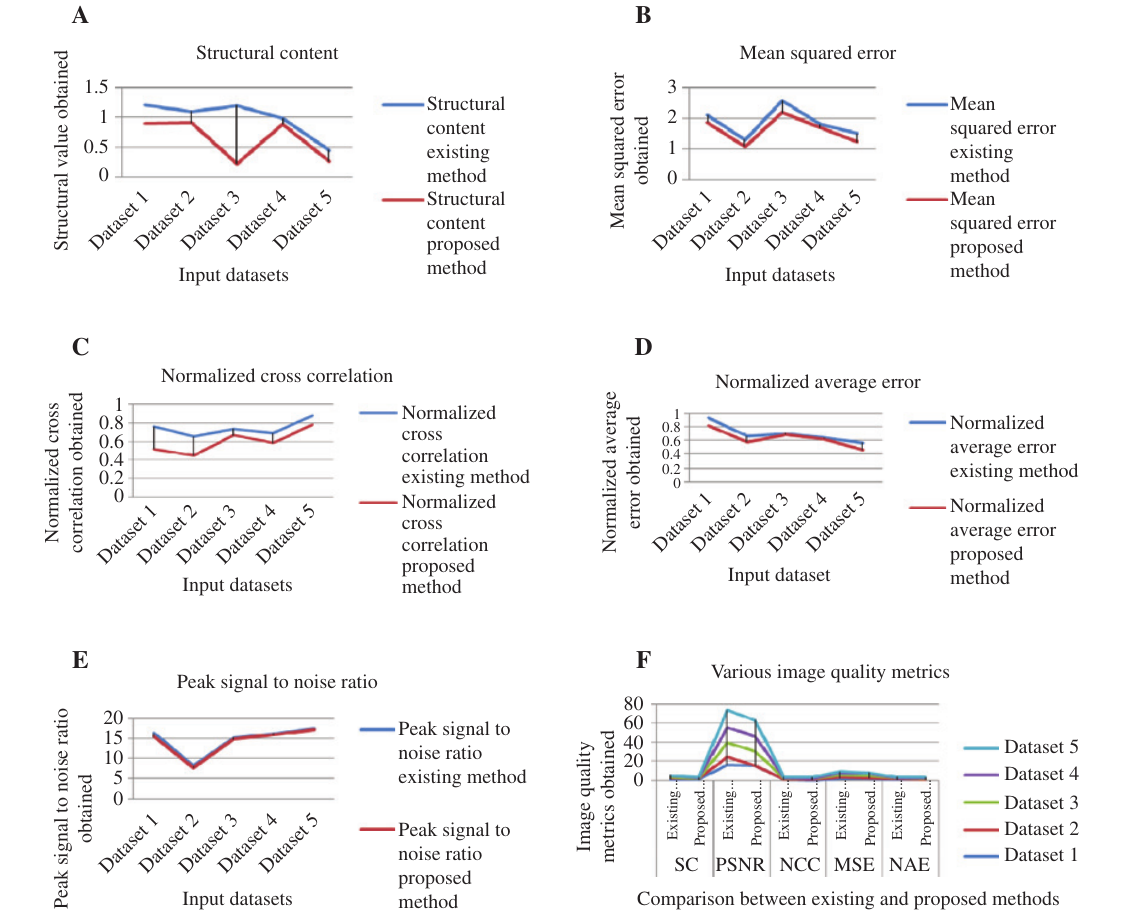
Figure 4: Comparative Graphical Illustration of Various Quality Metrics with Existing Methods. (A) Graphical depiction of structural content. (B) Graphical depiction of mean square error. (C) Graphical depiction of normal- ized cross correlation. (D) Graphical depiction of normalized average error. (E) Graphical depiction of peak signal to noise ratio. (F) Graphical depiction of various image quality